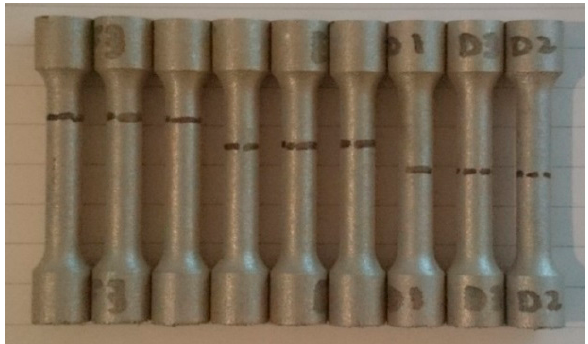
Figure 10. Customised specimen set failure points.